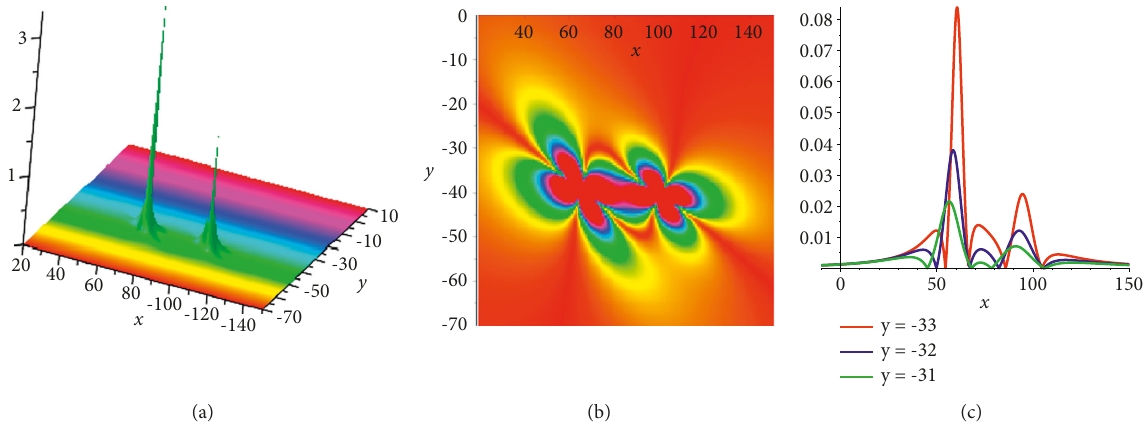
Figure 7: Plot of equation (50) by taking a � c � c f 2. (c) f 3.